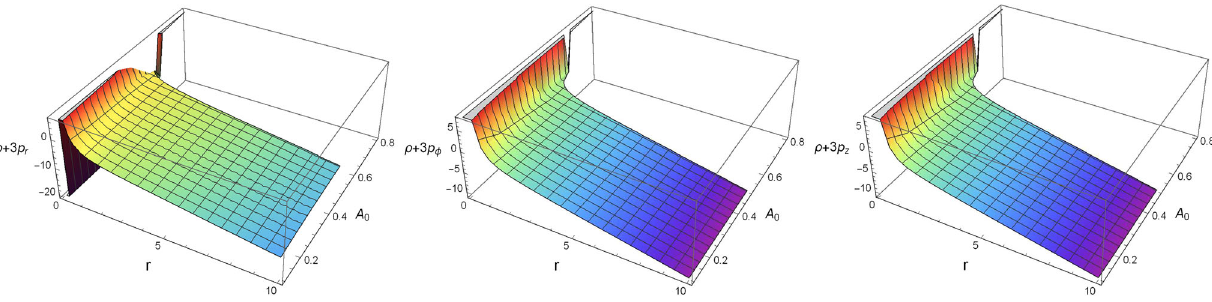
Fig. 3 This panel shows the behavior of (ρ + 3 p r ) (MeV/fm 3 ) , (ρ + 3 p φ ) (MeV/fm 3 ) and (ρ + 3 p z ) (MeV/fm 3 ) w.r.t r (km) with m = n = 1 and α = − 0 . 01. CASE